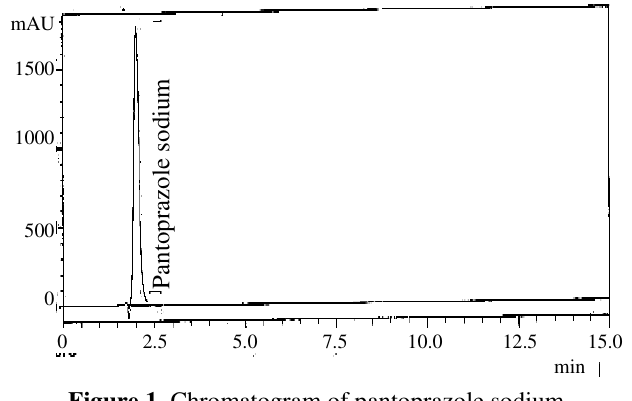
Figure 1 . Chromatogram of pantoprazole sodium.